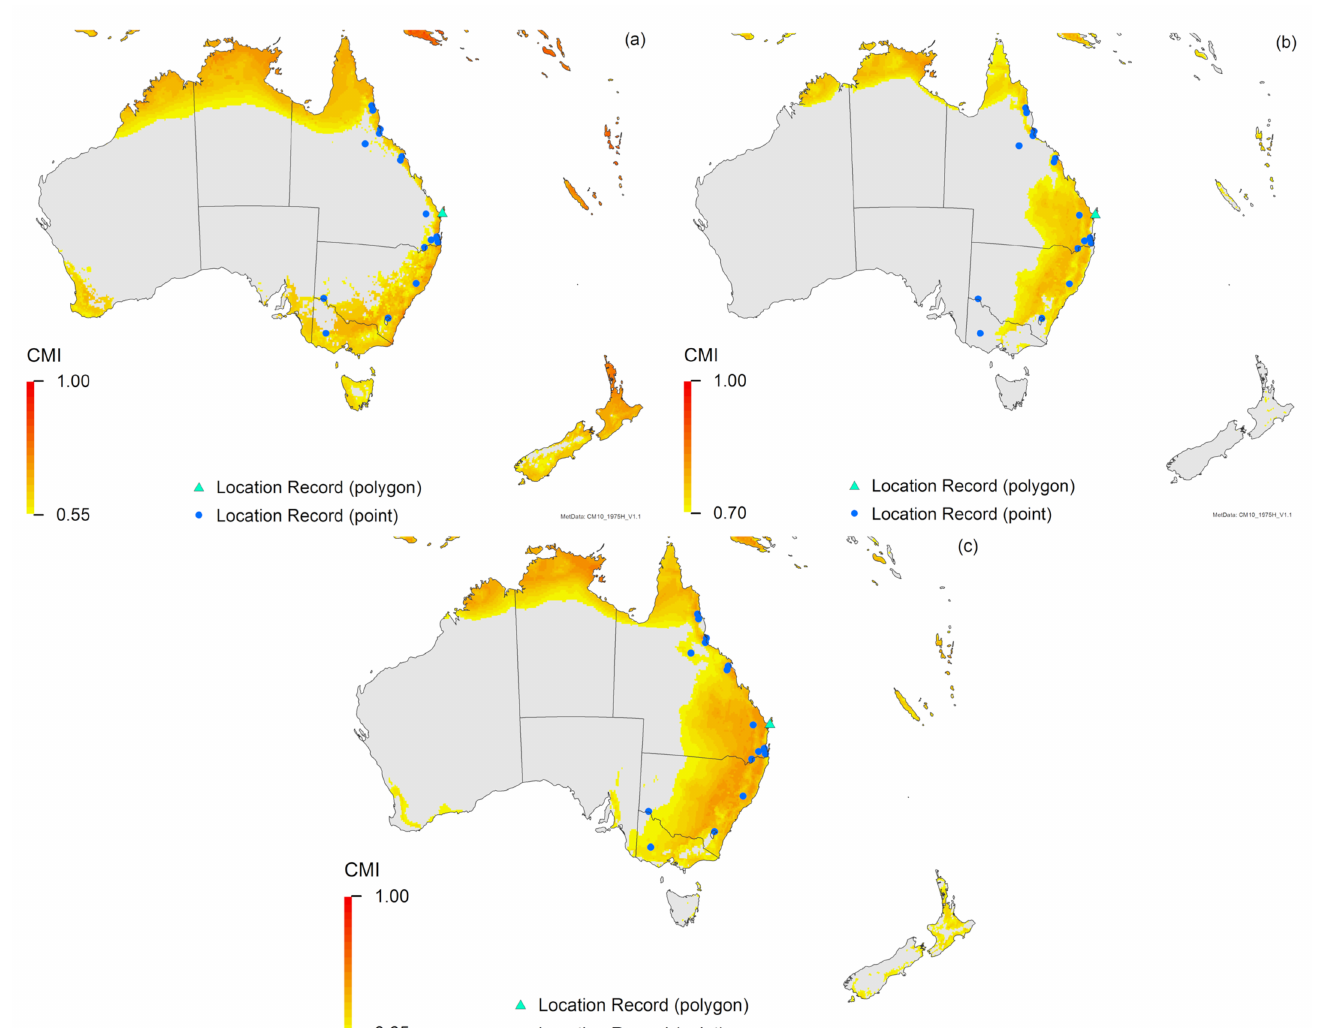
Figure A4. Composite map for Australia and New Zealand of the maximum CMI between native locations and the rest of the world: ( a ) Regional Match Climate (RMC) using minimum and maximum temperature and soil moisture, CMI > 0.55; ( b ) RMC using minimum and maximum temperature, rainfall amount and pattern, CMI > 0.70; ( c ) RMC using minimum and maximum temperature, rainfall amount and pattern, CMI > 0.65. Location records are for Trissolcus mitsukurii : circles are point location records; triangles are polygon